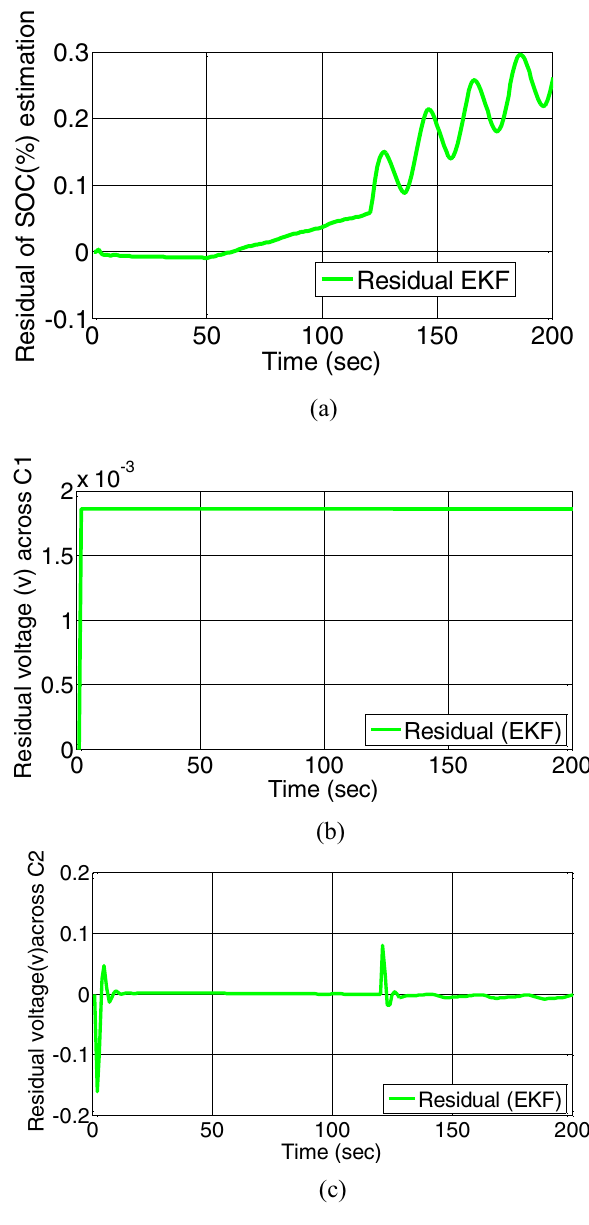
Figure 11. ( a ) Residual estimation of SOC, ( b ) residual estimation of voltage across charge transfer capacitance. ( c ) Residual estimation of voltage across double layer capacitance by